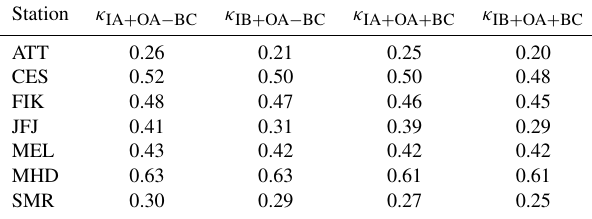
Table 2. Median values (based on all data) for the bulk par- ticle composition-derived hygroscopicity parameter kappa ( κ ) at each station with particle chemical composition measurements. The subscripts to κ indicate which species were or were not in- cluded: “IA + OA − BC” for inorganic aerosol and organic aerosol mass but no black carbon; “IB + OA − BC” for ion-balanced in- organic aerosol and organic aerosol mass but no black carbon; “IA + OA + BC” for inorganic aerosol, organic aerosol mass and black carbon; and “IB + OA + BC” for ion-balanced inorganic aerosol, organic aerosol mass and black